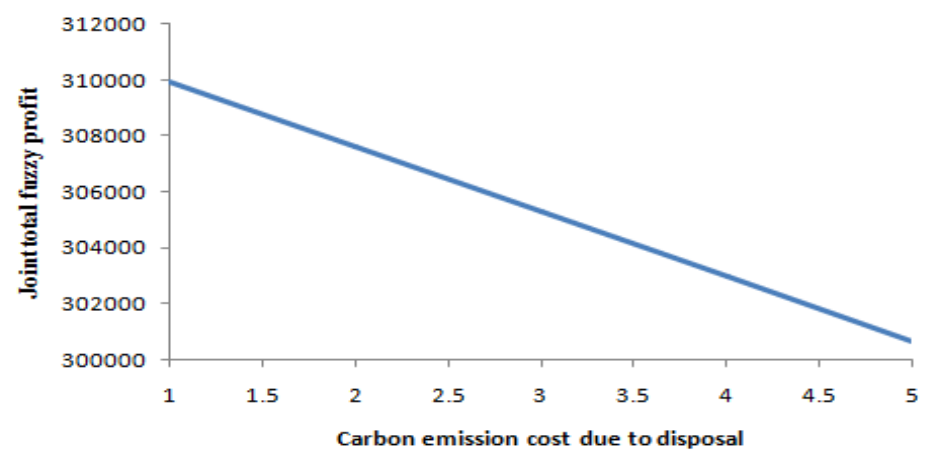
Figure 13. The carbon emission cost due to disposal vs. the total fuzzy profit.